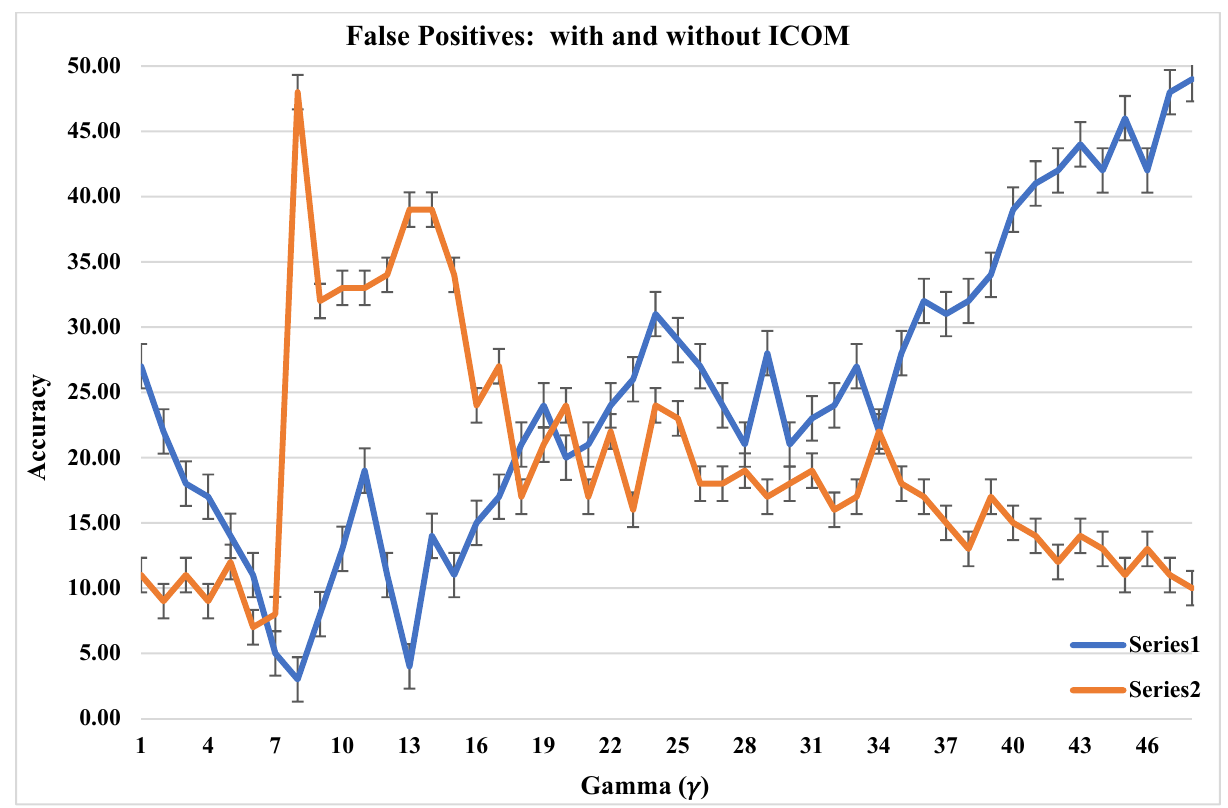
Figure 9. Effect of Gamma ( γ ) on Accuracy and false negatives. The Accuracy and false negatives are illustrated in Figure 10 as a comparison with different models. The graph displays that the ideal Gamma 𝛾 (on x -axis) with low Accu- racy and high false negatives (on y -axis) is high. Although every malicious message can- not be classified, the IoT devices having low computing resources as compared to the at- tacker still display higher Accuracy and false negatives on running the anomaly detection models.